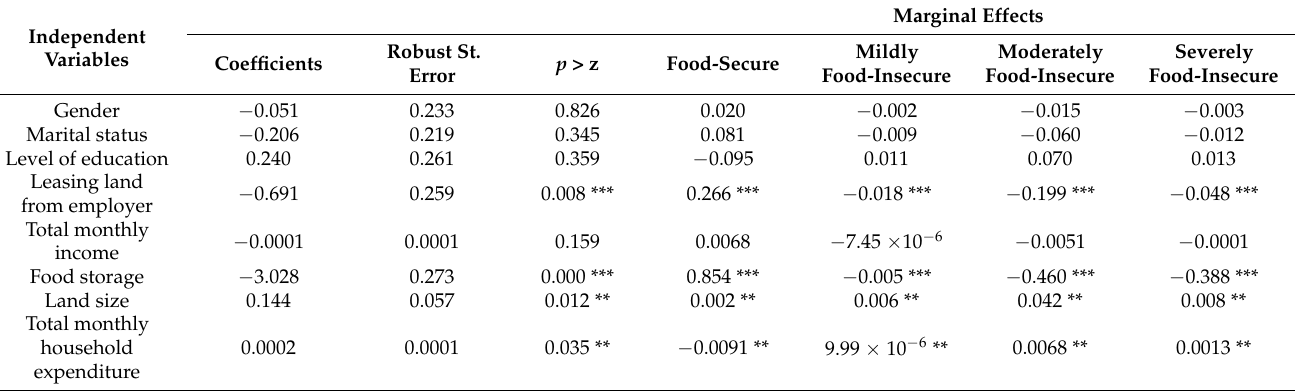
Table 4. Ordered probit results of determinants of household food